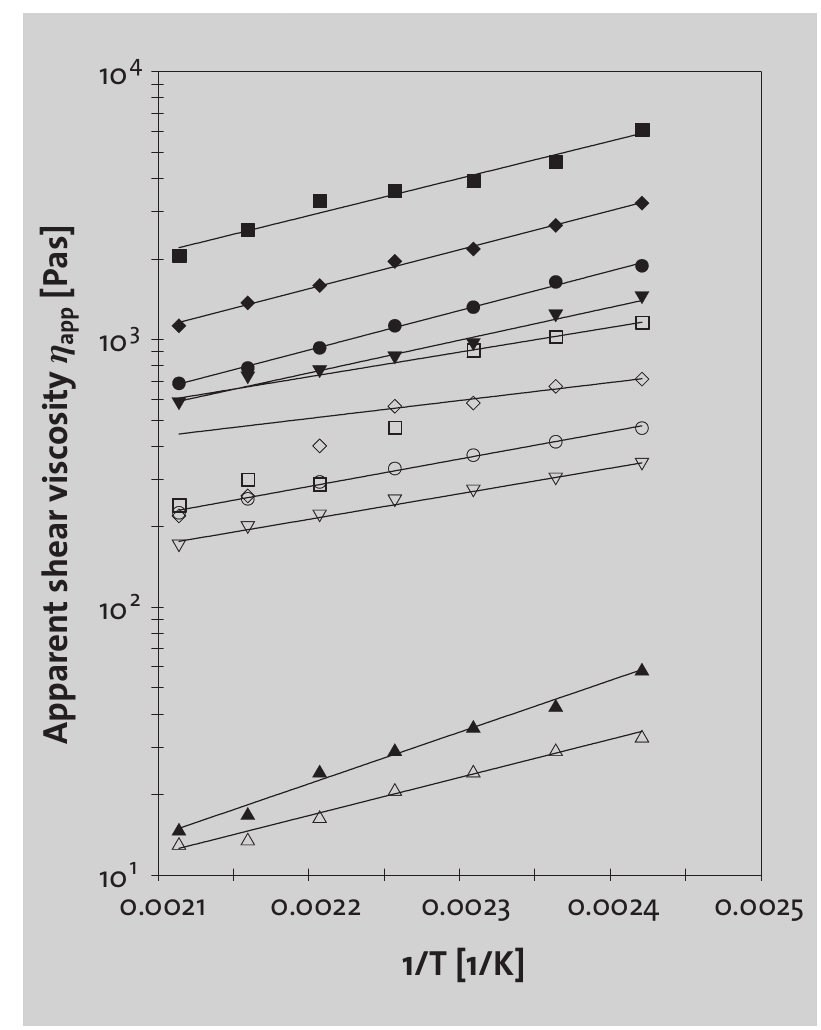
Figure 6 (above): Apparent shear vis- cosity vs. reciprocal absolute temper- ature for pure binder ( Û ) and com- pounds containing 40 ( Ùı ) 45 ( ÊÁ ), 50 ( ÏÌ ) and 55 ( ‡· ) vol. % carbide powder at apparent shear rates 50 (solid symbols) and 1000 (open sym- bols) s-1(Goettfert, L CAP /D CAP ratio 20/1). Table 3 (below): Activation energy of the shear flow of PIM compounds.